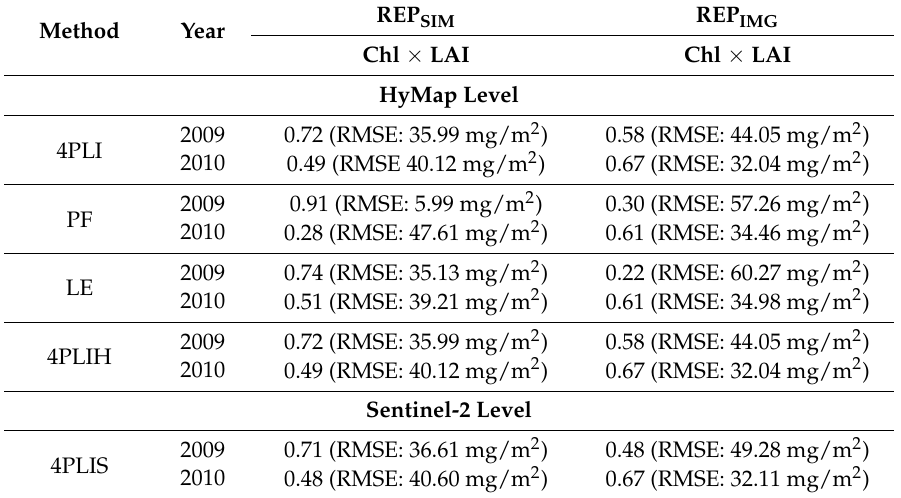
Table 3. R 2 and RMSE describing the relationship of the REP SIM /REP IMG and Chl × LAI